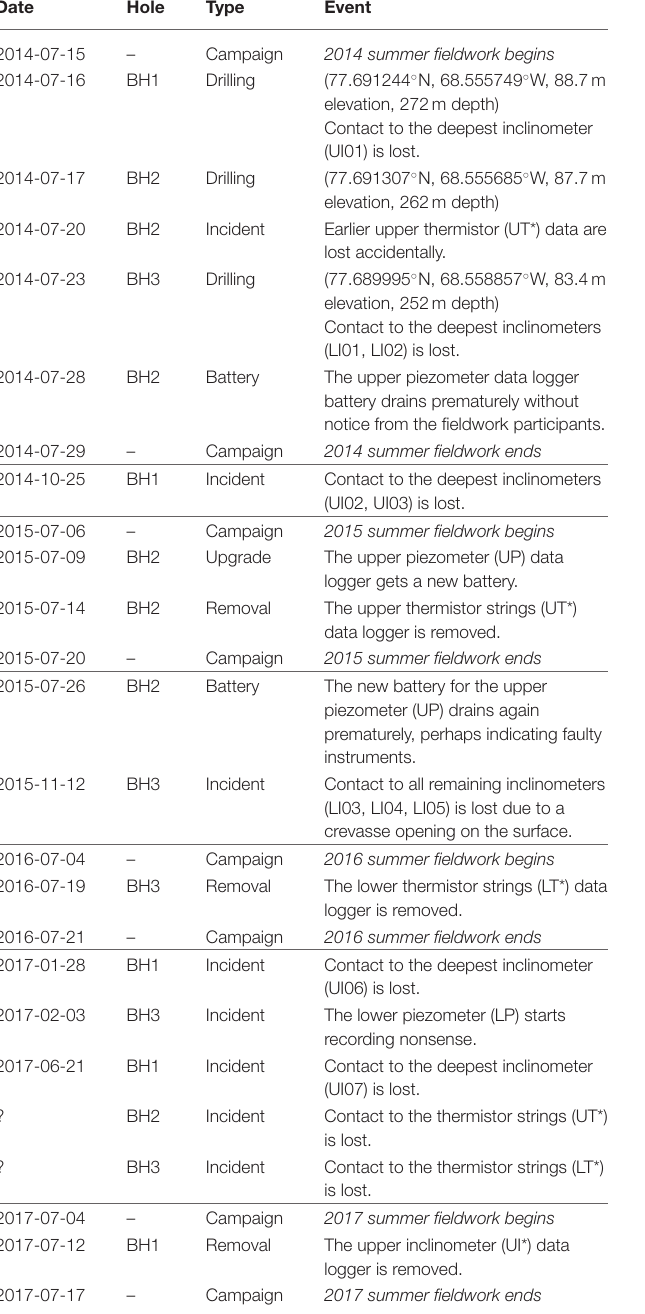
TABLE 2 | Temperature calibration coefficients and melt offset